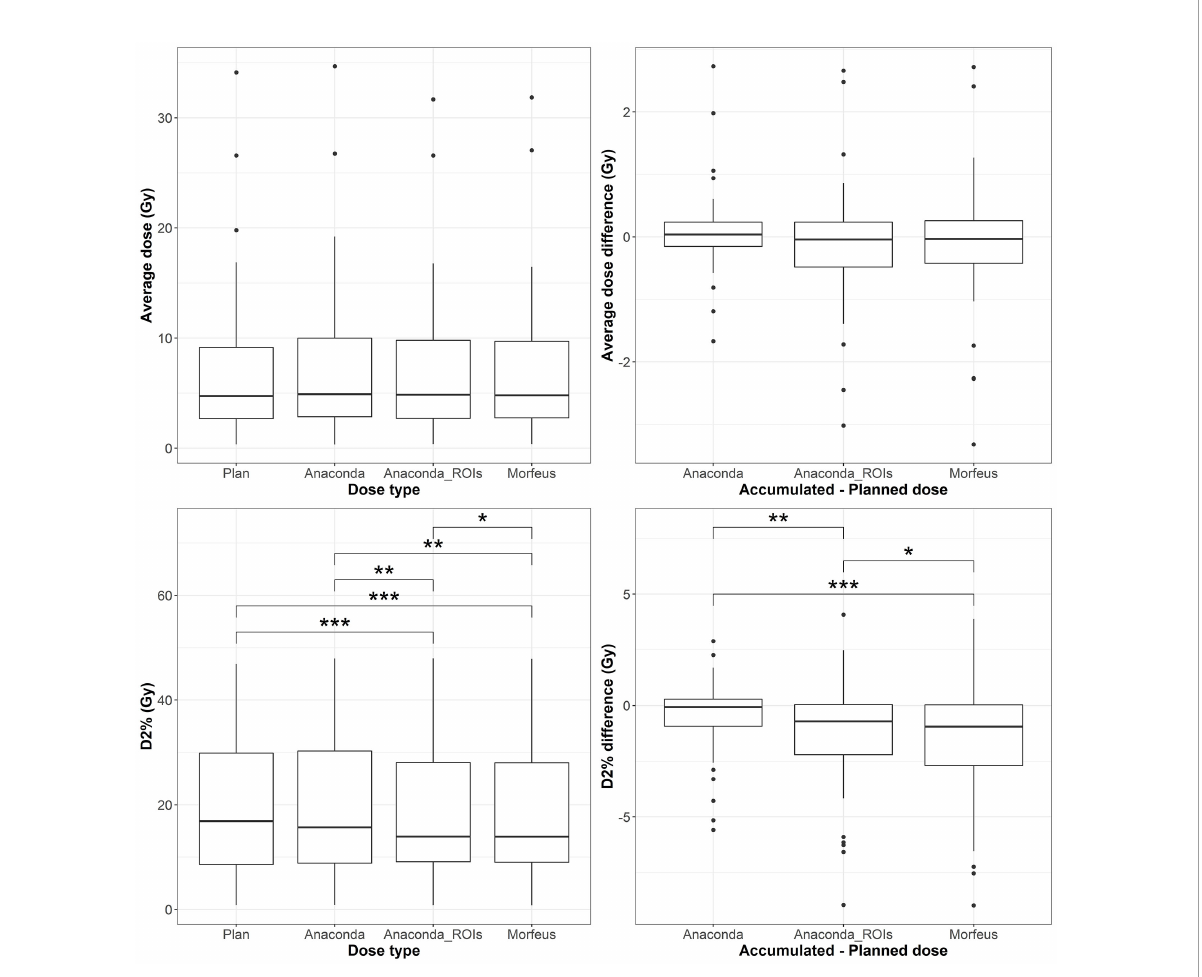
FIGURE 5 Left:average(top row)andmaximum(bottowrow)planned andaccumulatedStomach EQD2(Gy).Right:differencebetweenaccumulatedandplanned doses. Statistically signi fi cantdifferencesbetweenmeansareindicatedaccordingtoBonferroni-adjustedp-values(*p<0.05;**p